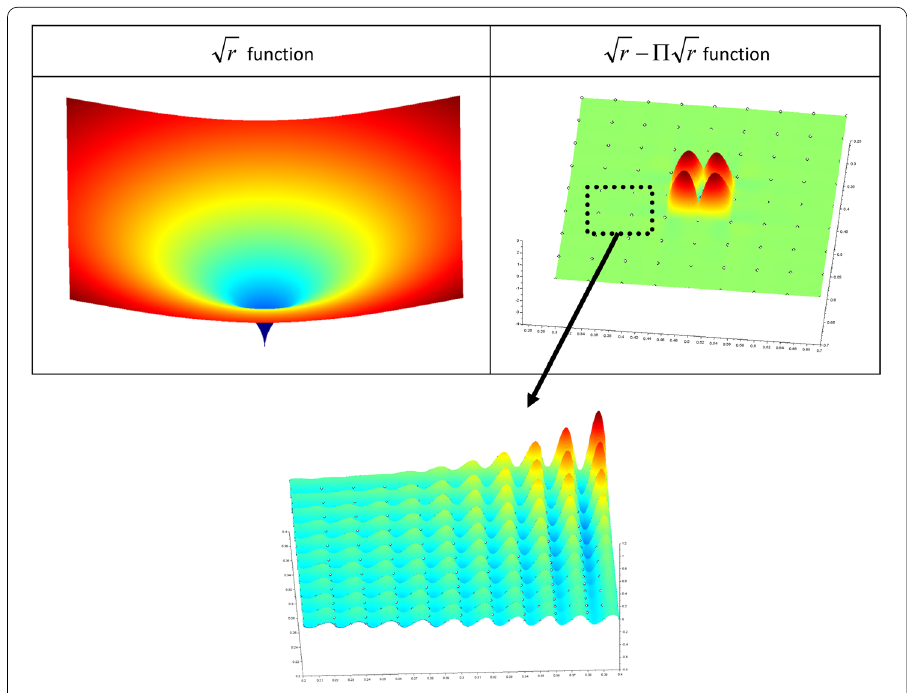
Fig. 7 “Straightforward” enrichment class versus “bubble” enrichment class. The difference in shape highlights the difference in behavior stated in the previous section